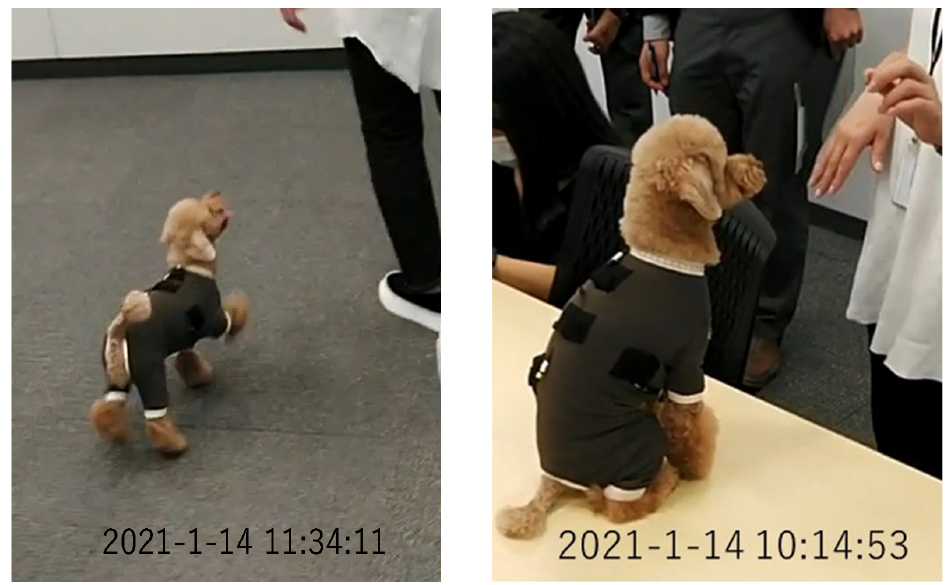
Figure 14. Clip of video footage of a toy poodle taken with a video camera installed in a conference room during the experiment.